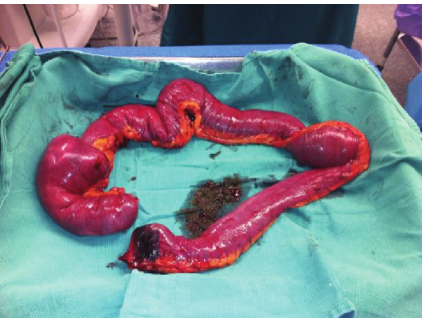
Figure 2: Surgical specimen of small bowel with metastatic extraskeletal myxoid chondrosarcoma, grade 2/3, to the bowel and mesenteric fat with secondary intussusception and bowel obstruction.